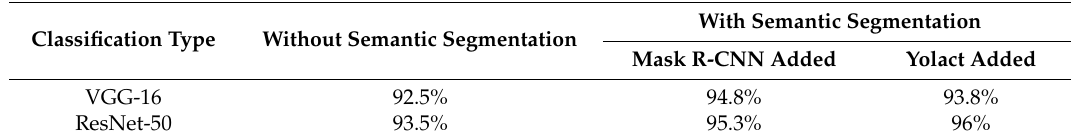
Table 3. Accuracy of Shot Type Classification.